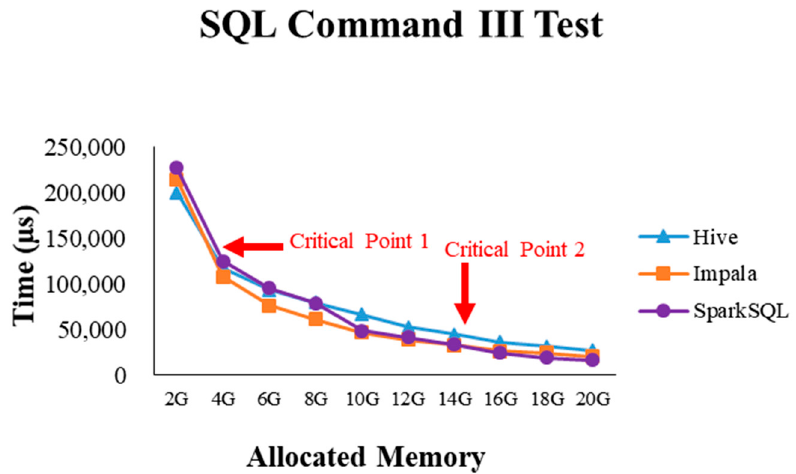
Figure 8. The average execution time of one record by SQL command II.